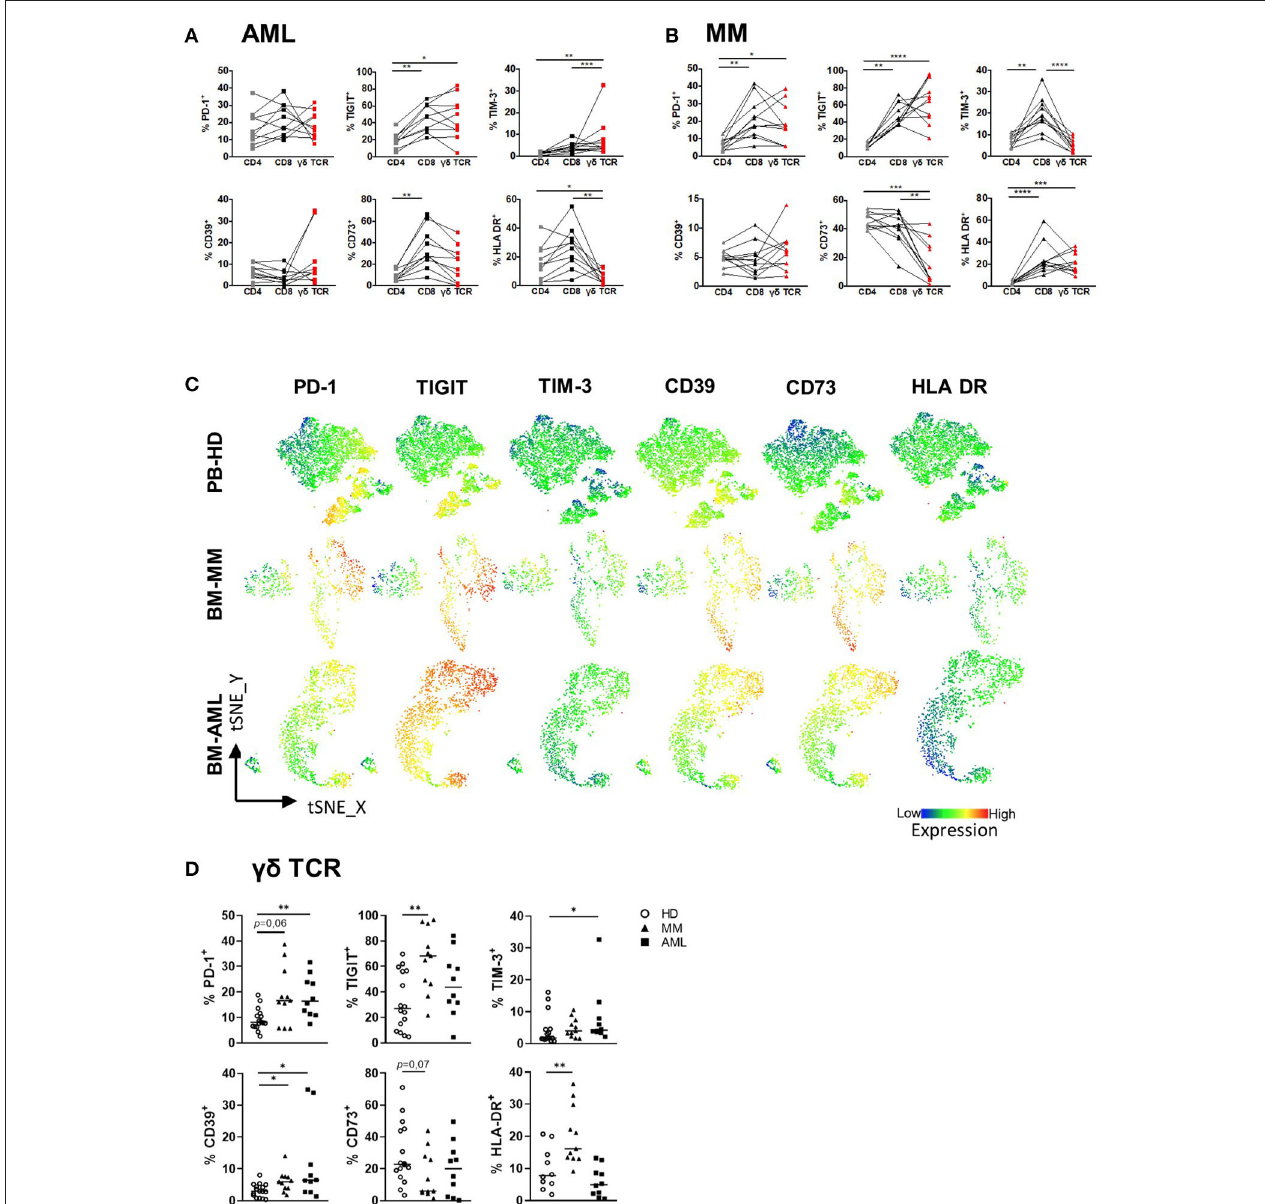
FIGURE 3 | PD-1, TIGIT, TIM-3, and CD39 are expressed by γδ T cells in AML and MM. The surface expression of PD-1, TIGIT, TIM-3, CD39, CD73, and HLA-DR was investigated on CD4 + , CD8 + , and γδ T cells by using multicolor flow analysis for healthy donors (HD, n = 16), patients with multiple myeloma (MM, n = 11), and newly diagnosed AML patients (AML, n = 10). (A,B) Summary data illustrating the frequency of PD-1, TIGIT, TIM-3, CD39, CD73, and HLA-DR on CD4 + cells (gray squares/triangles), CD8 + T cells (black squares/triangles), and γδ T cells (red squares/triangles). P -values were obtained by the ANOVA and Friedmann test. * P < 0.05, ** P < 0.01, *** P < 0.001, **** P < 0.0001. (C) T-distributed stochastic neighbor embedding (tSNE) analysis demonstrate the distribution of PD-1, TIGIT, TIM-3, CD39, CD73, and HLA-DR on V δ 1 and V δ 2 γδ T cells within the total γδ T cells in BM aspirates from four HDs (upper graphs), four patients with MM (middle